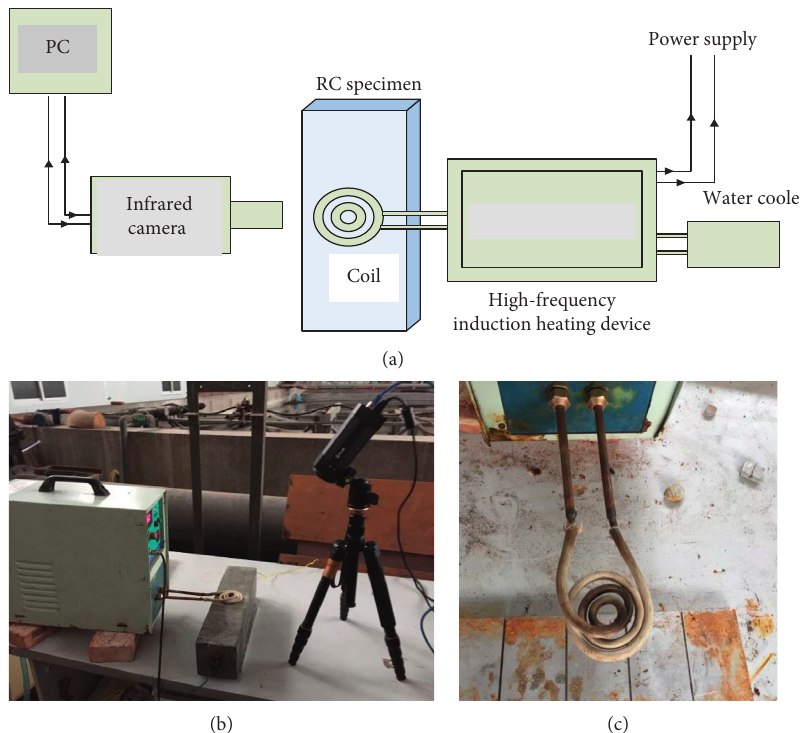
Figure 2: (a) A schematic diagram of the high-frequency induction heating and infrared detection system, and real photographs of (b) the experimental setup and (c) the heating